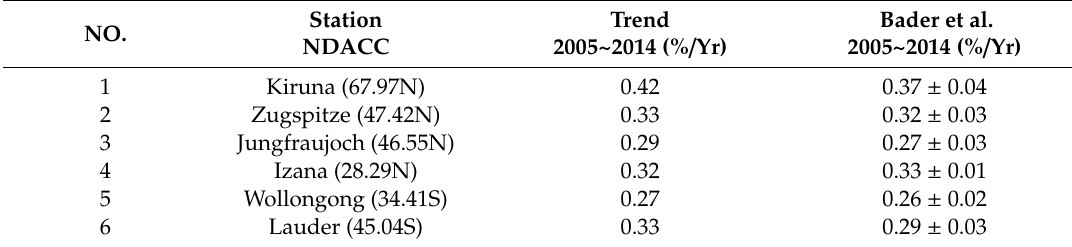
Table 3. EEMD-based annual increase rates of X ch4 at six NDACC stations during 2005–2014 and those from Bader et al.